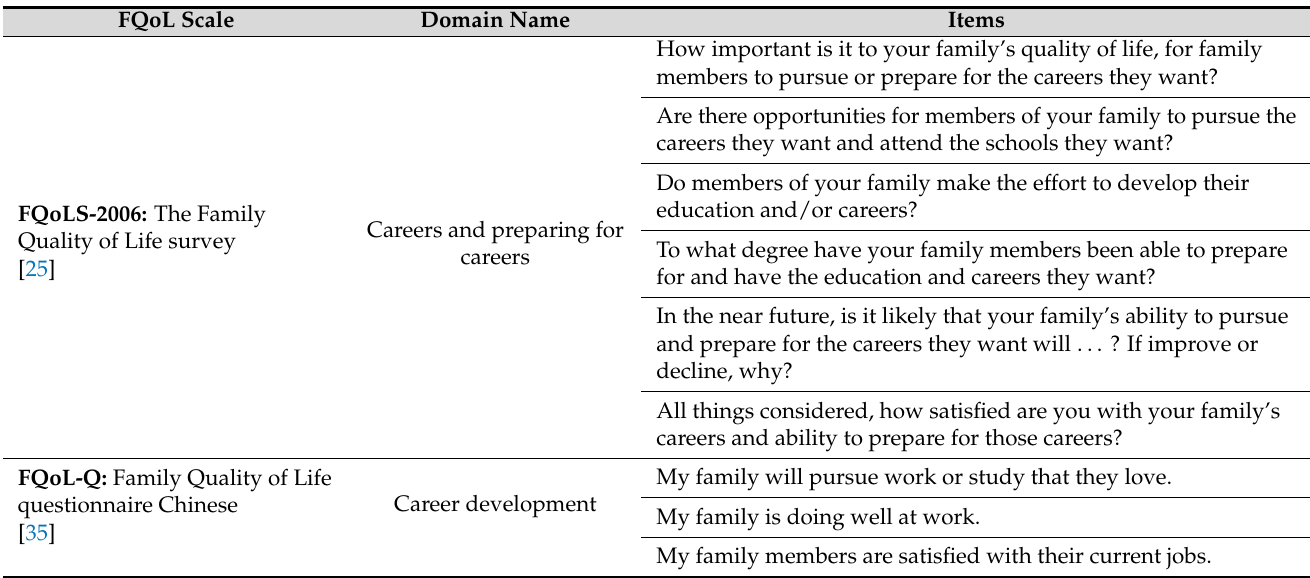
Table 14. Items considered in the domain of careers/career development within each FQoL